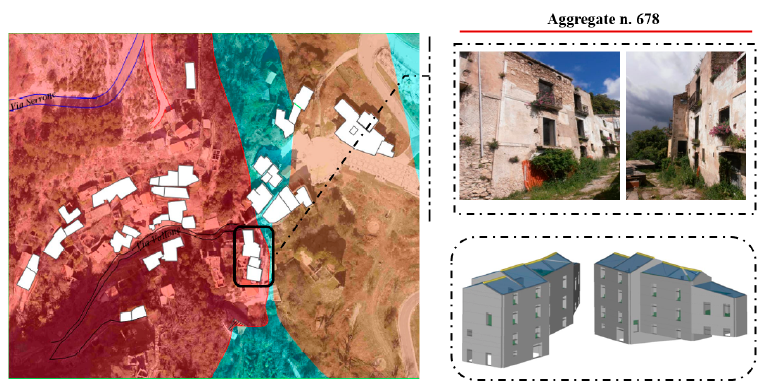
Figure 12. The identification and structural macroelement model of a typical urban aggregate.